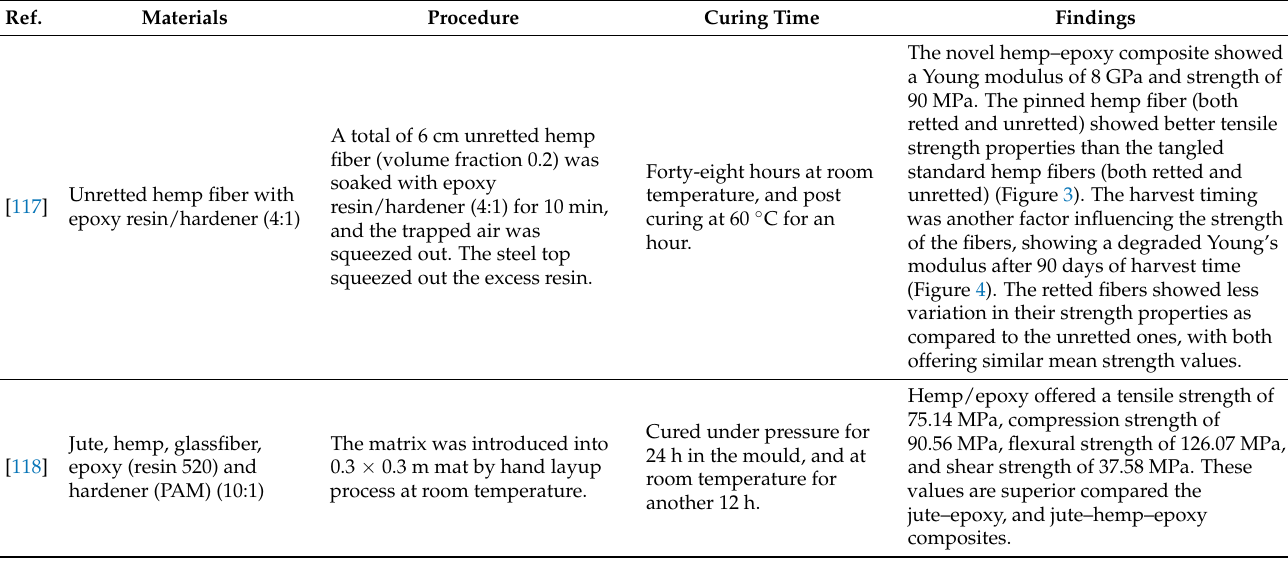
Table 4. Mechanical properties of hemp-based biocomposite